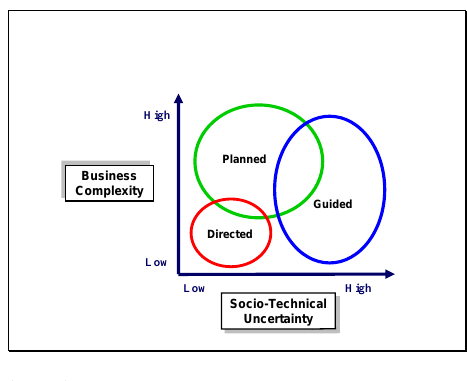
Figure 3 : Complexity, Uncertainty and Approaches to Change